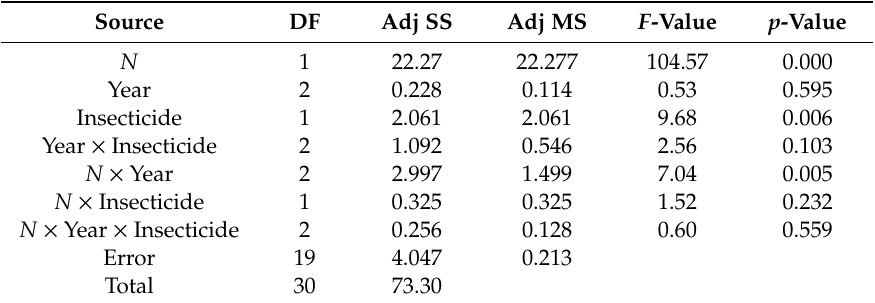
Table 2. Analysis of Variance table for defoliation against L 4 larval density ( N ), year, and insecticide treatment (Equation (2)).